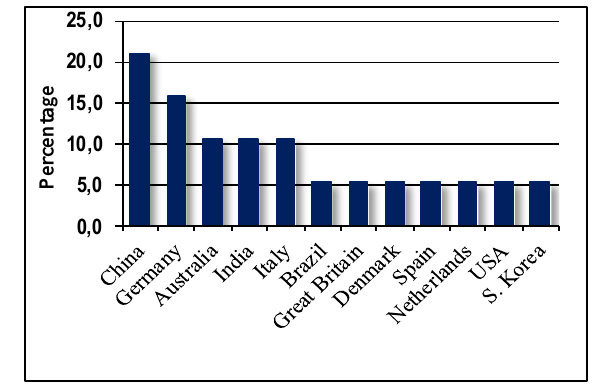
Figure 14. Countries that made major contribution in research related to mobile 2D and 3D mapping and development of spatial services (2012)